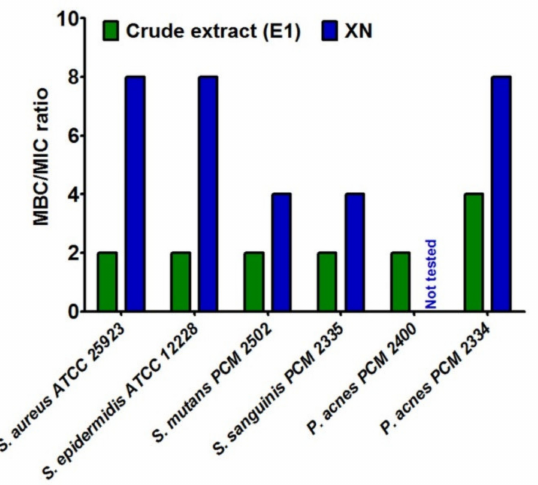
Figure 1. The ratio between minimal bactericidal concentration (MBC) and minimum inhibitory concentration (MIC) for compounds from Marynka hop